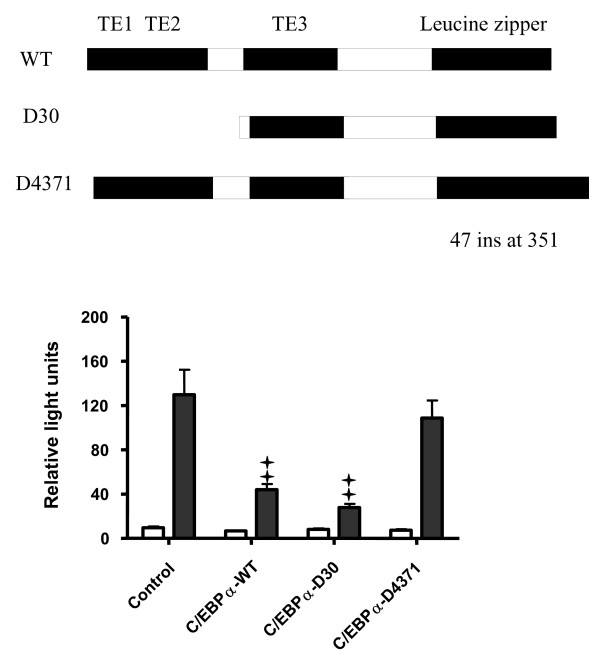
Effect of isoforms and a C-terminal mutation of C/EBPα on PSA promoter activity. LNCaP cells were transfected with PSA promoter/enhancer-driven luciferase reporter construct and expression vectors of C/EBPα expressing the wild type (WT) holoprotein, a mutated C/EBPα (D30) that gives rise to a protein identical to the p30 isoform of C/EBPα formed by an alternative initiation codon, and a C-terminal mutant (D4371) of C/EBPα formed by a 47 amino acid insertion at amino acid position 351. Luciferase activity was measured as in Figure 4. A. Schematic representations of the p42 and p30 isoform of C/EBPα and the C-terminal mutant protein (2). B. Expression of luciferase activity from the reporter construct after transfection with 100 ng of cDNA for C/EBPα p42 (wild type, WT), p30 isoform (D30), or C-terminal mutated cDNA (D4371) in LNCaP cells in the presence (dark bars) or absence (open bars) of DHT. The results expressed as relative light units are the means ± standard deviation of 3 separate experiments. Dark double stars signify statistical significance at p-value < 0.01 compared with control in DHT-stimulated transcription activity.